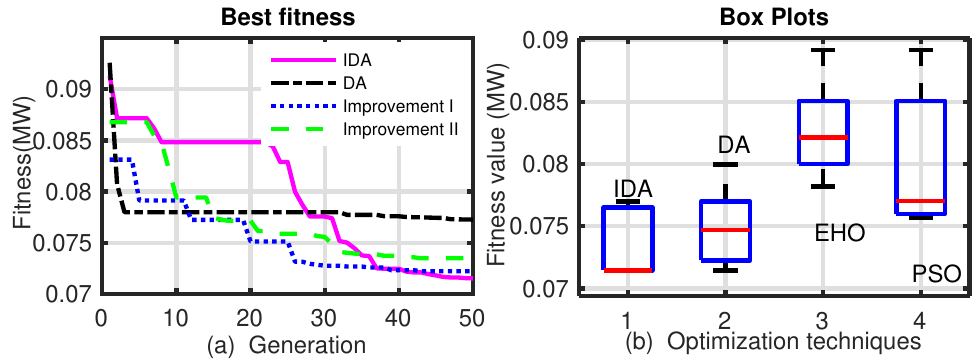
Figure 1. ( a ) Comparison of convergence characteristics of DA, improvements, and IDA. ( b ) Box plot of solution archived from IDA, DA, EHO, and PSO for power losses minimization in an ADN.